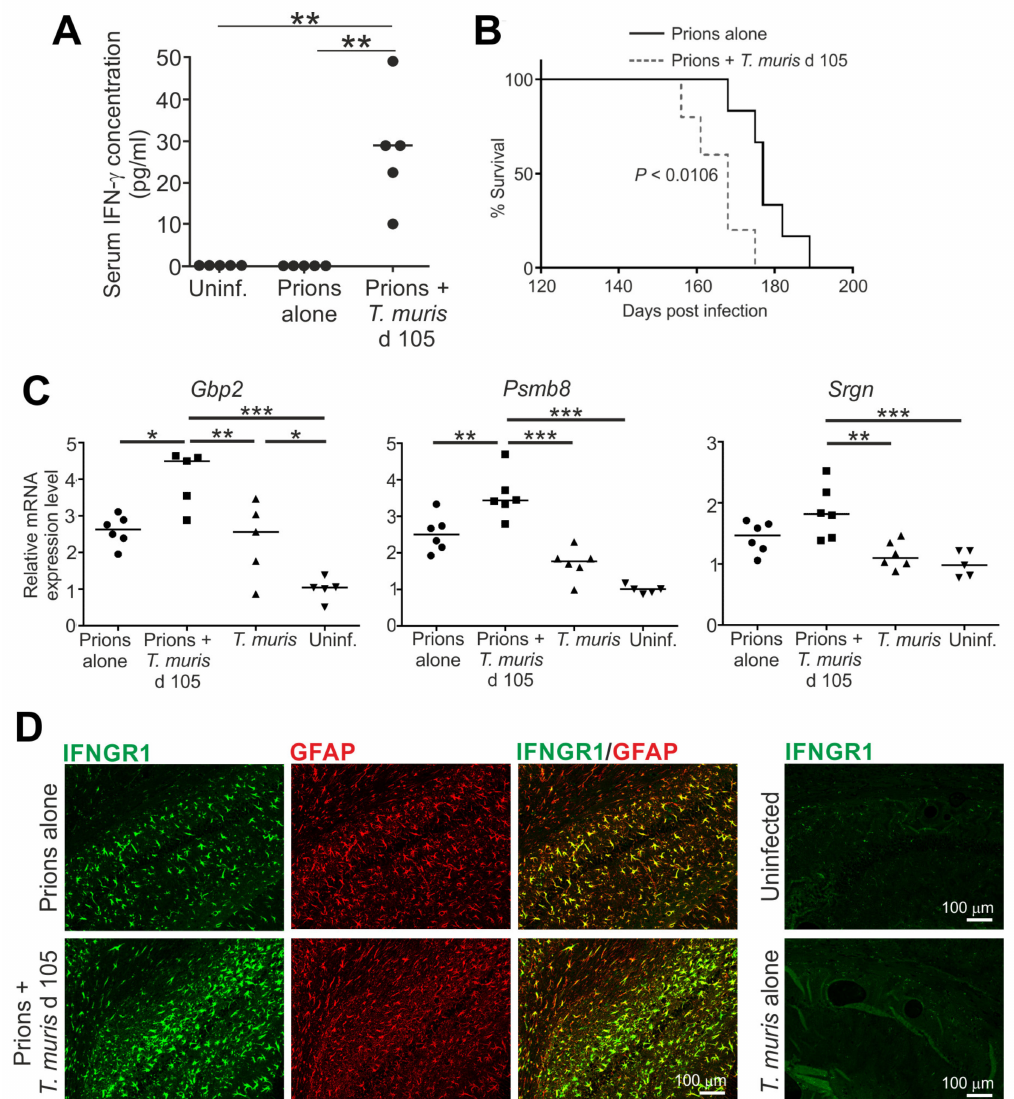
Figure 8. Accelerated CNS prion disease in mice co-infected with a gastrointestinal helminth during the preclinical phase [213]. Mice were injected IC with ME7 scrapie prions and 105 days later they were orally co-infected with ~20 infective T. muris eggs. Mice were sampled 35 days later (d 140) or maintained until the development of clinical disease. ( A ) High levels of IFN- γ in the serum of mice co-infected with prions and T. muris . ( B ) Survival plot shows accelerated onset of clinical prion disease in mice co-infected with prions and T. muris . ( C ) Significantly increased expression of the A1 reactive astrocyte-associated genes Gbp2 , Psmb8 and Srgn in the brains of mice co-infected prions with T. muris . ( D ) Immunofluorescent microscopical detection of high levels of IFNGR1 (green) in GFAP + reactive astrocytes (red) in the brains of mice infected with prions alone or co-infected with prions and T. muris . *, p < 0.05; **, p < 0.01; ***, p < 0.001. Figure adapted from [213] under the terms